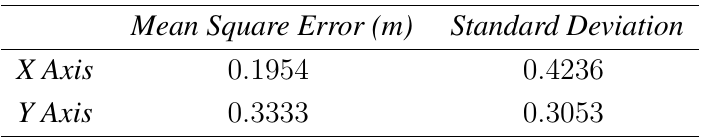
Table 1. Mean Square Error and Standard Deviation of the calculated obstacle